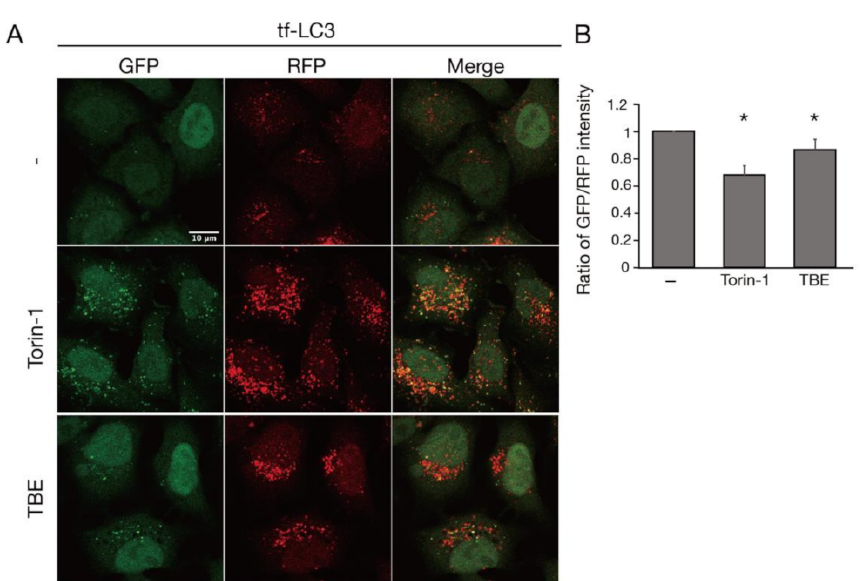
Figure 1. TBE induces autophagy progression. ( A ) Tf-LC3-expressing HeLa cells were treated with or without Torin-1 or TBE for 6 h under nutrient-rich conditions. Bar:10 µ m. ( B ) The graph shows the signal intensity ratio of GFP/RFP in each field of view after 6 h. Median: line; upper and lower quartiles: boxes; 1.5 interquartile range: whiskers. * denotes p < 0.05 by unpaired two-tailed Student’s t